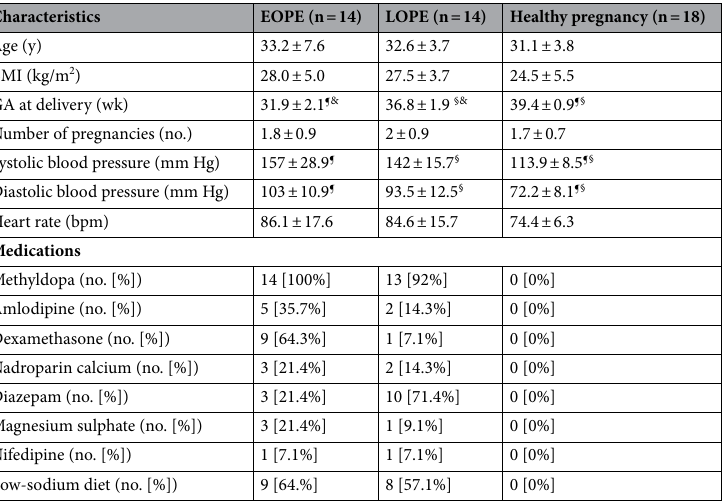
Table 2. Summary of patients’ characteristics (validation/targeted proteomics set). BMI, body mass index; bpm, beats per minute; EOPE, early-onset pre-eclampsia; GA, gestational age; LOPE, late-onset pre-eclampsia. ¶ , P < 0.05 of a characteristic between EOPE and healthy pregnancy groups. § , P < 0.05 of a characteristic between LOPE and healthy pregnancy groups. & , P < 0.05 of a characteristic between EOPE and